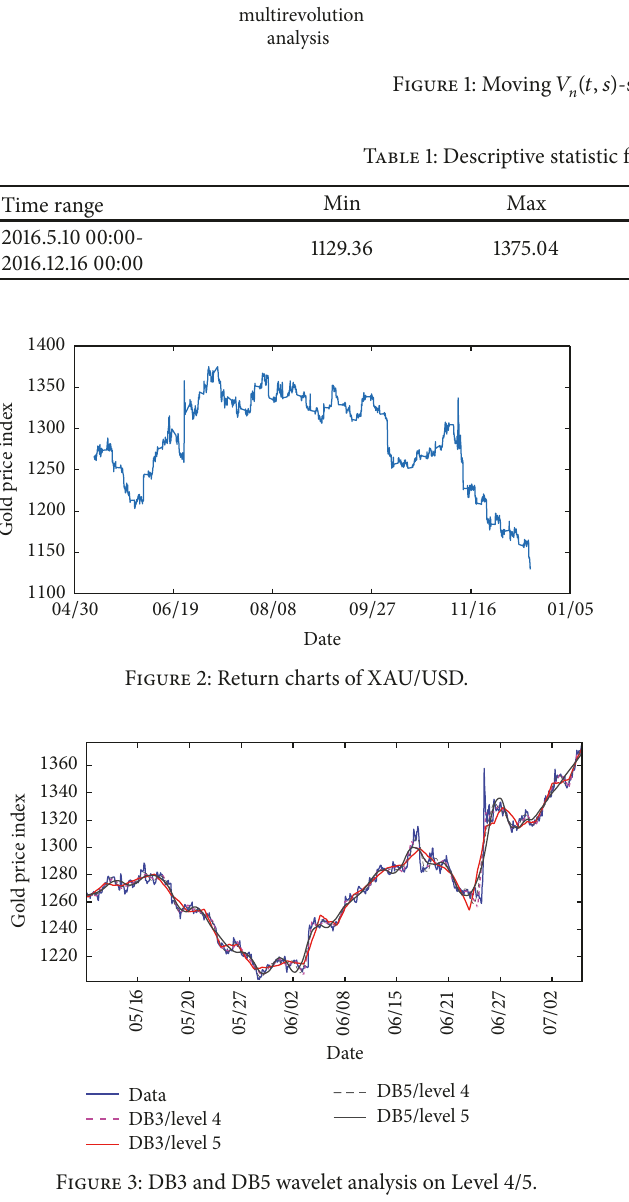
Figure 3: DB3 and DB5 wavelet analysis on Level 4/5.